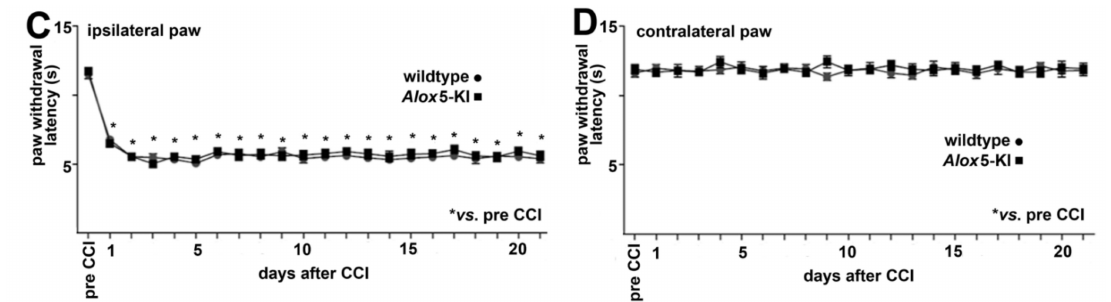
Figure 7. Comparison of Alox5 -KI and wildtype mice in the CCI model of neuropathic pain. Mechanical sensitivity assessed by the von Frey test in paws ipsilateral ( A ) and contralateral ( B ) to the CCI. The decrease in the paw withdrawal threshold indicates mechanical hypersensitivity. Heat sensitivity assessed by the Hargreaves test in paws ipsilateral ( C ) and contralateral ( D ) to the CCI. The decrease in the paw withdrawal latency indicates heat hypersensitivity. * p < 0.001 vs. values before CCI induction (pre-CCI), one-way repeated measures ANOVA and Bonferroni’s multiple comparison test. Data are expressed as means ± SEM. n = 9 male mice per